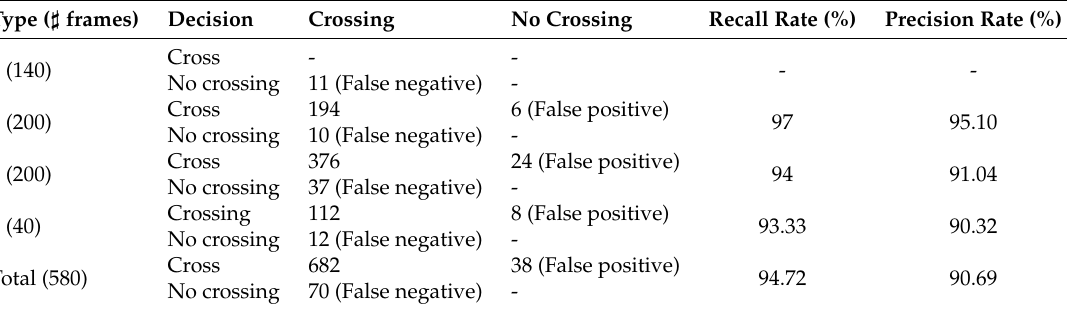
Table 2. Summary of pedestrian crossing detection results on data set